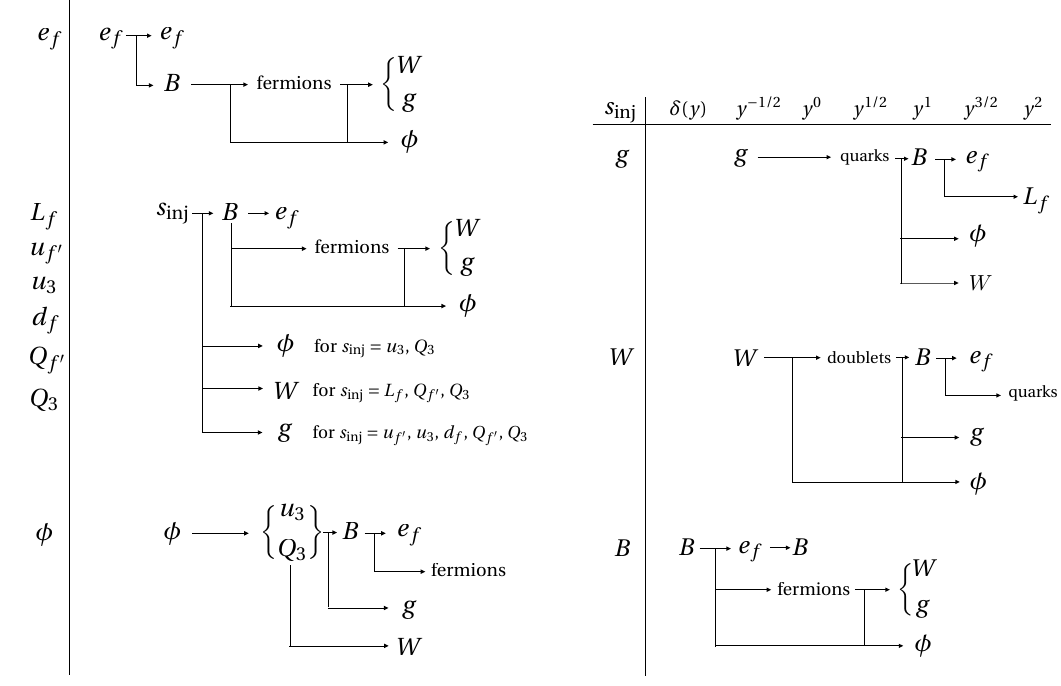
Figure 2 . Cascades of primary particles. The leftmost part represents the primary particles s inj . Particle production occurs from left to right, as indicated by the arrows. The horizontal axis represents the behavior of distributions at p ≈ p 0 , indicated by the function of y ≡ ( p 0 − p ) /p 0 ( (cid:28) 1 ) at the first line. “fermions” represents the fermions that are not already produced in the cascades. For the case of s inj = e f and B , the distribution of primary particles is a delta function plus some function of y . For the other cases, the distribution of primary particles is proportional to y − 1 / 2 without δ ( y )